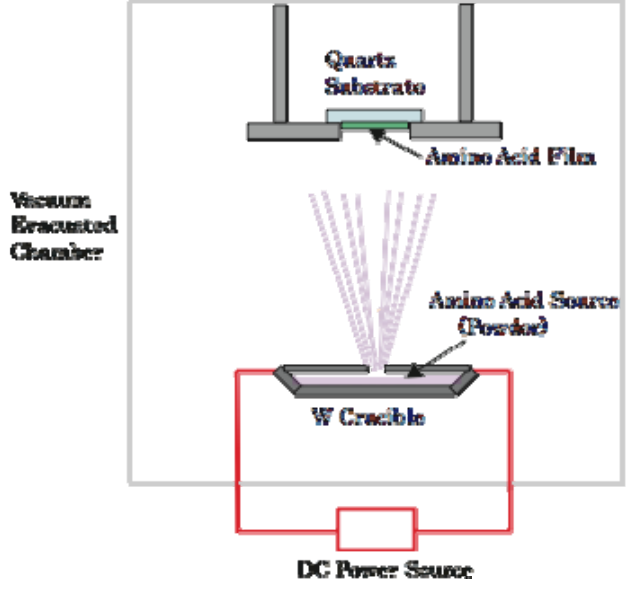
Figure 14. Schematic view of the vacuum evaporation system. Dimension of the chamber is 500 x 500 x 800 mm 3